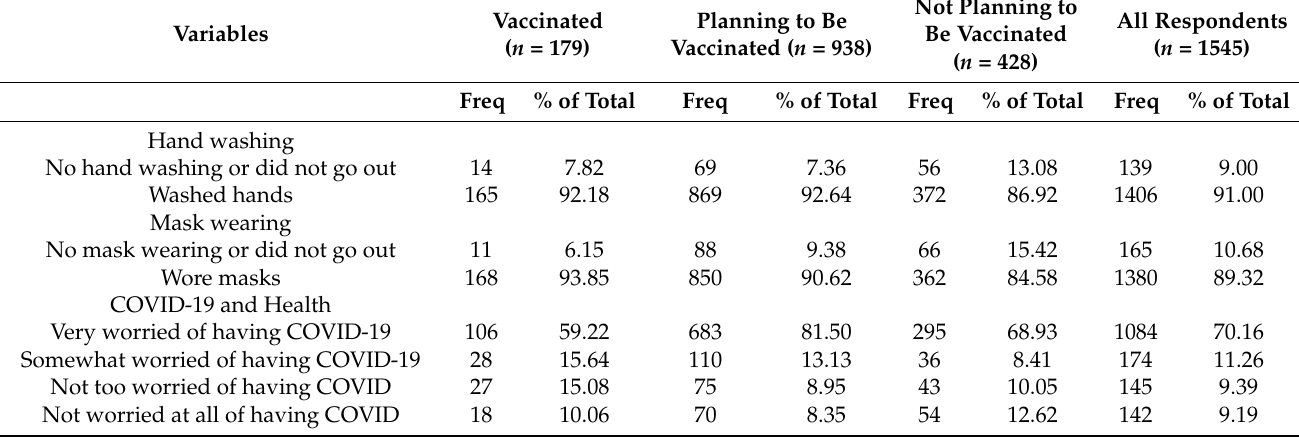
Table 2. Respondents’ Perceptions of Vulnerability to COVID-19, Safety Compliance and Vaccination